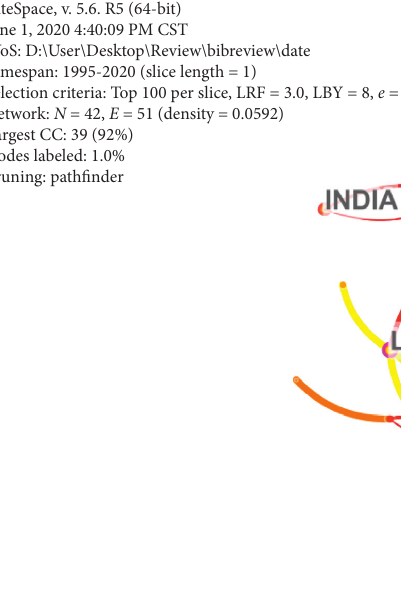
Figure 10: Network of countries in the field of DC/EP. Table 9: Contributions of countries on